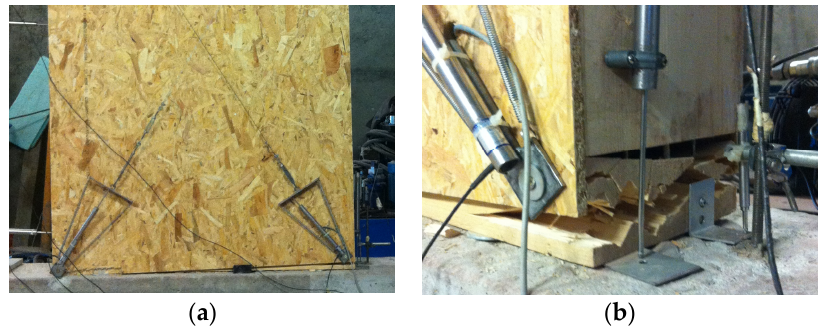
Figure 10. Specimen D: ( a ) Deformation of the sample and; ( b ) Rotation failure.